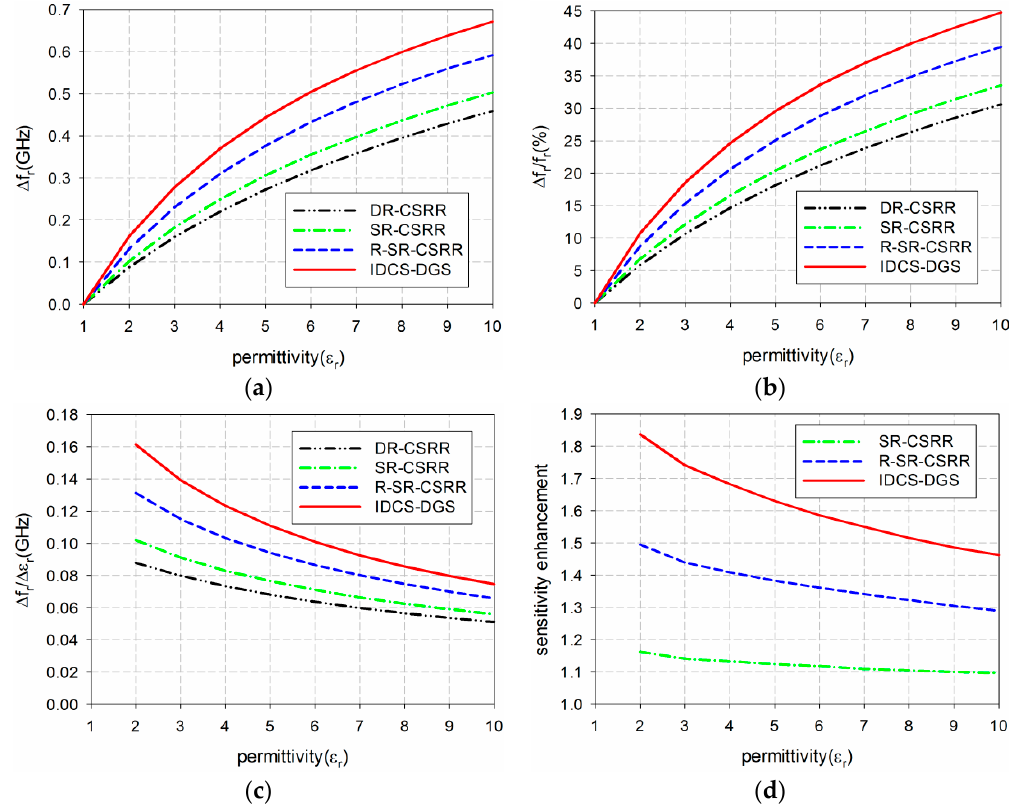
Figure 7. Sensitivity comparison of the four permittivity sensors: ( a ) frequency shift ( Δ f r (GHz)); ( b ) percent relative frequency shift ( Δ f r /f r (%)); ( c ) sensitivity( Δ f r / Δ ε r (GHz)); ( d ) sensitivity enhancement compared to the DR-CSRR-based sensor.